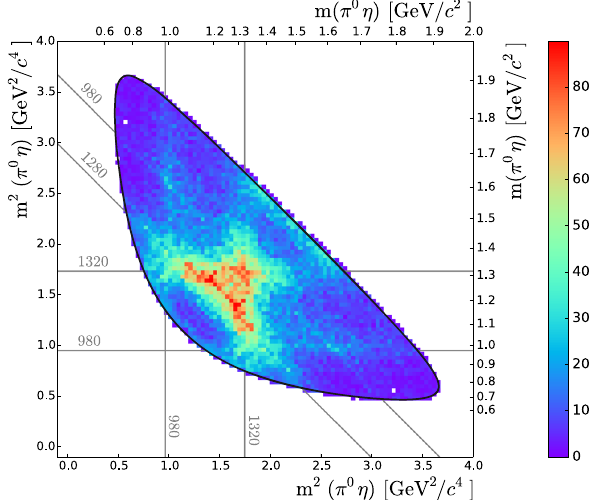
Fig. 3 Dalitz plot for the π 0 π 0 η data after application of the back- ground suppression, not corrected for acceptance. Some resonance masses of interest are marked with thin black lines and gray labels (two entries per